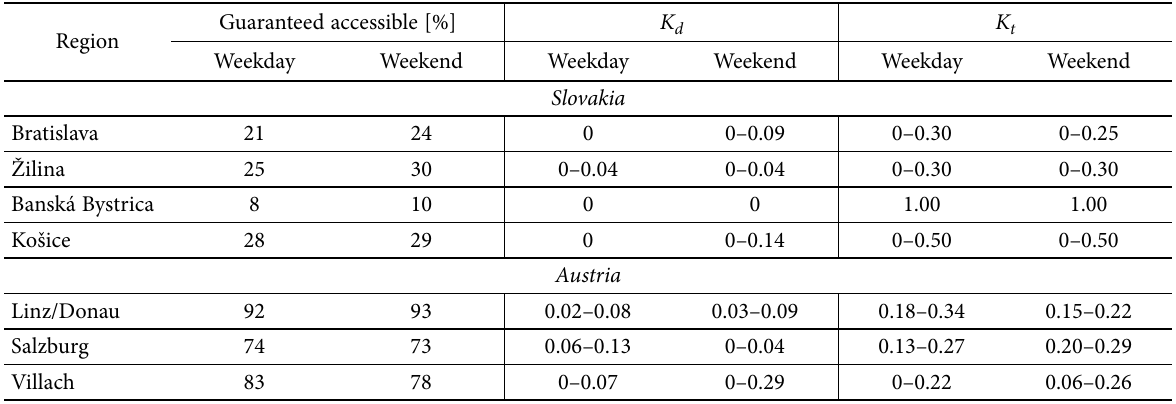
Fig. 3. Guaranteed accessible trains proportion in Austria, Czech Republic and Table 6. Trains accessibility comparison in Slovakia and Austria